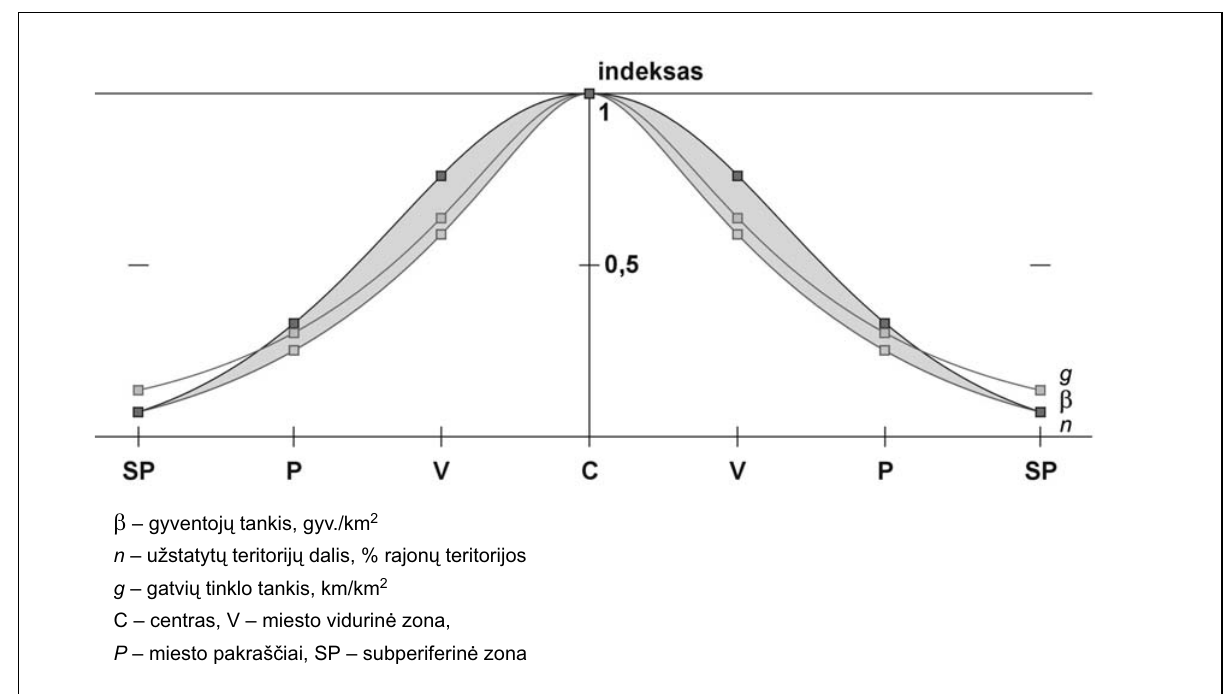
Fig 8. Vilnius physical structure disproportions according to the citizens’ estimation results,